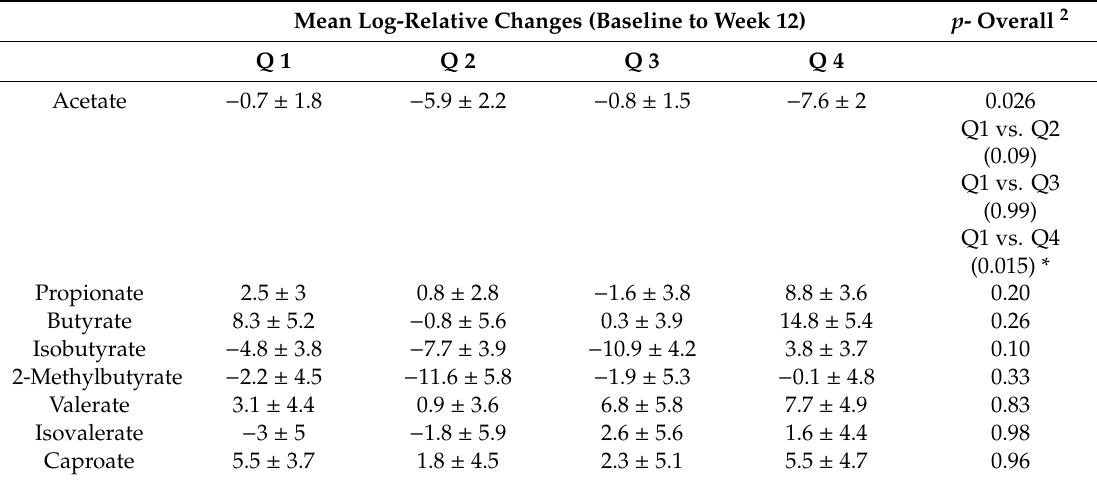
Table 2. E ff ects of weight loss on plasma SCFA concentrations between quartiles of weight loss 1 . Mean Log-Relative Changes (Baseline to Week